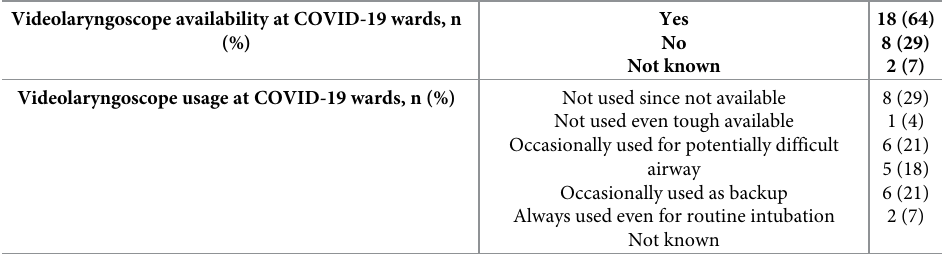
Yes 18 (64) No 8 (29) Not known 2 (7) Not used even tough available Occasionally used for potentially difficult airway Occasionally used as backup Always used even for routine intubation Not known